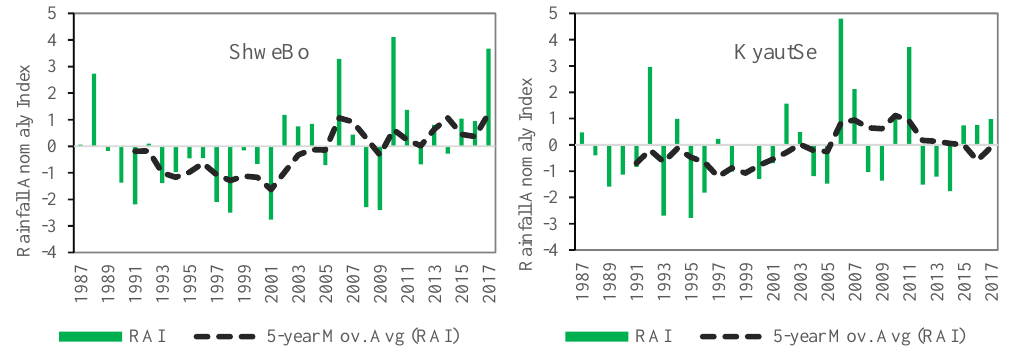
Figure 2. Rainfall anomaly index (RAI) and five-year moving average for ShweBo and KyautSe from 1987 and 2017.